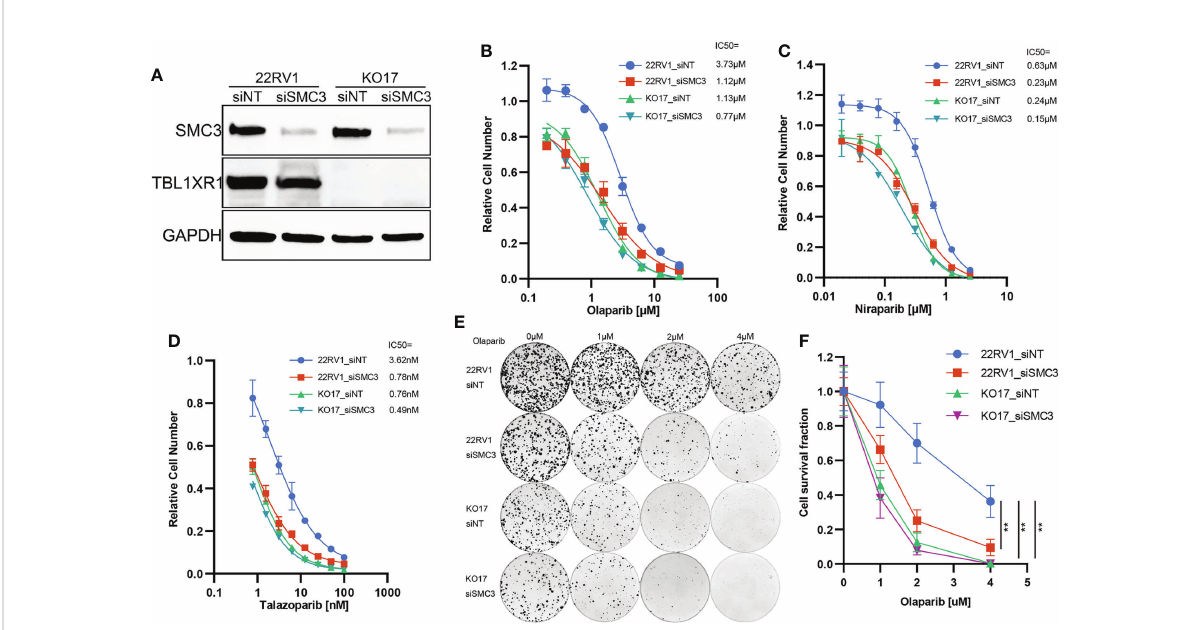
FIGURE 6 PARPi cytotoxicity and colony formation assay of SMC3 knockdown and TBL1XR1-SMC3 double knockdown (knockout) cells. (A) SMC3 knockdown ef fi ciency in 22RV1 and TBL1XR1-knockout cells. (B – D) Cytotoxicity of olaparib (B) , niraparib (C) and talazoparib (D) in 22RV1_siNT, 22RV1_siSMC3, KO17_siNT and KO17_siSMC3 cells. siNT, non-target siRNA. (E, F) Colony formation assay and cell survival fraction calculation in 22RV1_siNT, 22RV1_siSMC3, KO17_siNT and KO17_siSMC3 cells. siNT, non-target siRNA. ** p